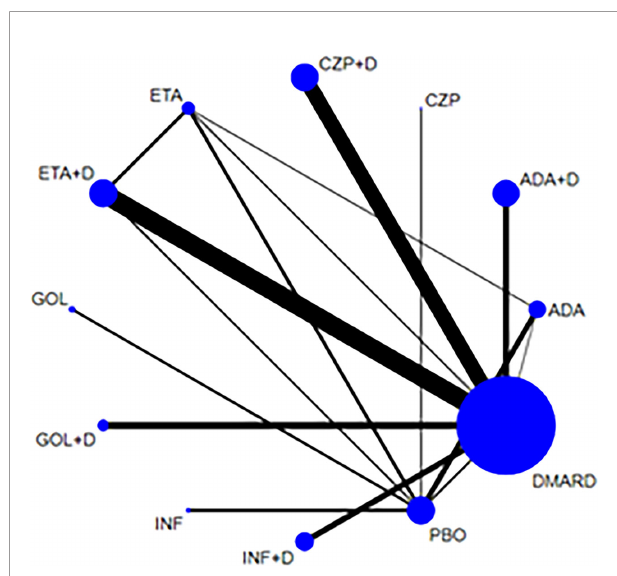
FIGURE 5 | Network of treatment comparisons for serious adverse events. The size of the circles corresponds to the total number of people. Direct comparable treatments are connected with a line. ADA, adalimumab; + D, plus DMARD; CZP, certolizumab; ETA, etanercept; GOL, golimumab; INF, in fl iximab; PBO, placebo; DMARD, disease-modifying anti-rheumatic drugs.